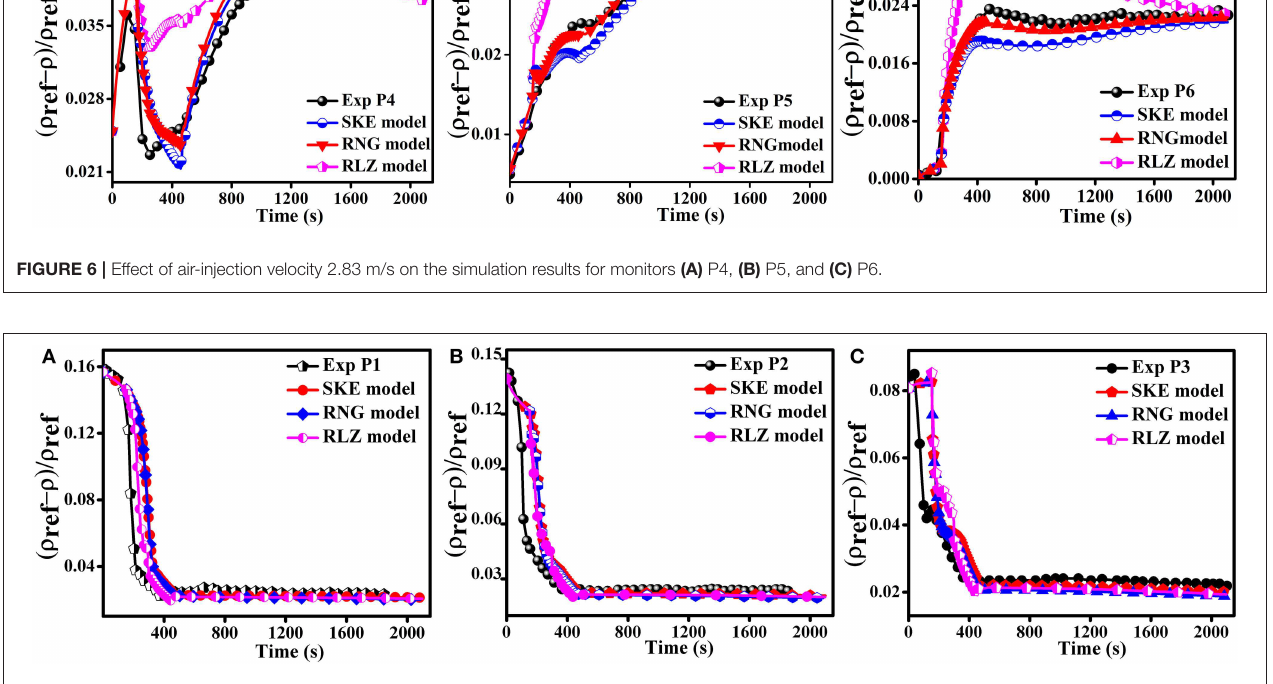
FIGURE 7 | Effect of air-injection velocity 5.143 m/s on the simulation results for monitors (A) P1, (B) P2, and (C) P3.